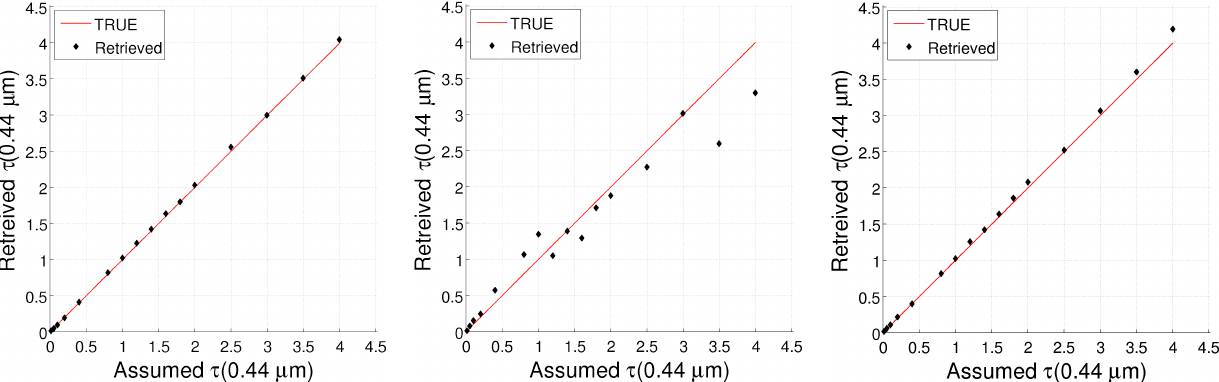
Fig. 12. Retrieval of desert dust optical thickness over Banizoumbou for 16 different aerosol loadings from τ (0.44µm)=0.01 to 4.0: (left panel) single-pixel retrieval with no noise added; (center panel) single-pixel retrieval with the random noise added; (right panel) multi-pixel retrieval with the random noise added.